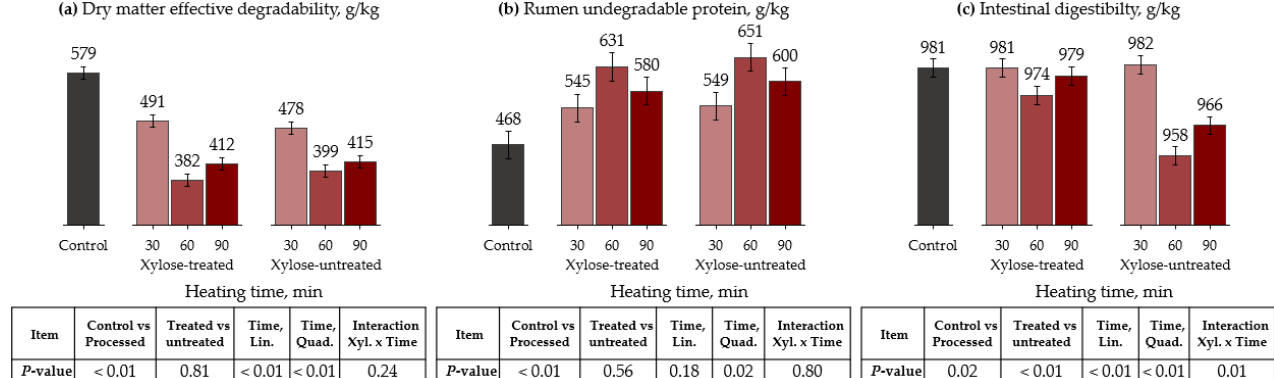
Figure 2. Effects of conventional oven heating and xylose treatment on dry matter effective degradability ( a , ED), rumen undegradable protein ( b , RUP), and intestinal digestibility ( c ) of peanut meal. ED = A + [B × kd/(kd + kp) × e -kt ] [31]; RUP = B × [kp/(kp + kd)], where A is the water-soluble fraction, g/kg; B is the potentially degradable water-insoluble fraction, g/kg; kd is the degradation rate of fraction B, h −1 ; t is time, h; and kp is the rumen passage rate (k) of 0.074 h −1 [32].